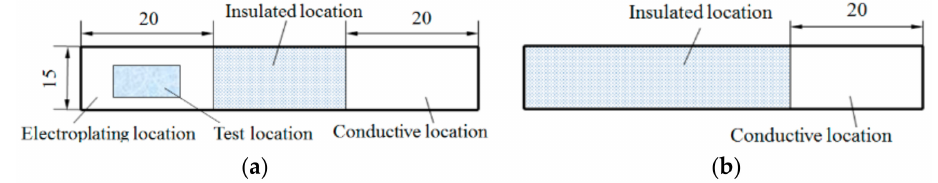
Figure 1. Q235Asubstratespecificationdiagram: ( a )Electroplatedsurface, and( b